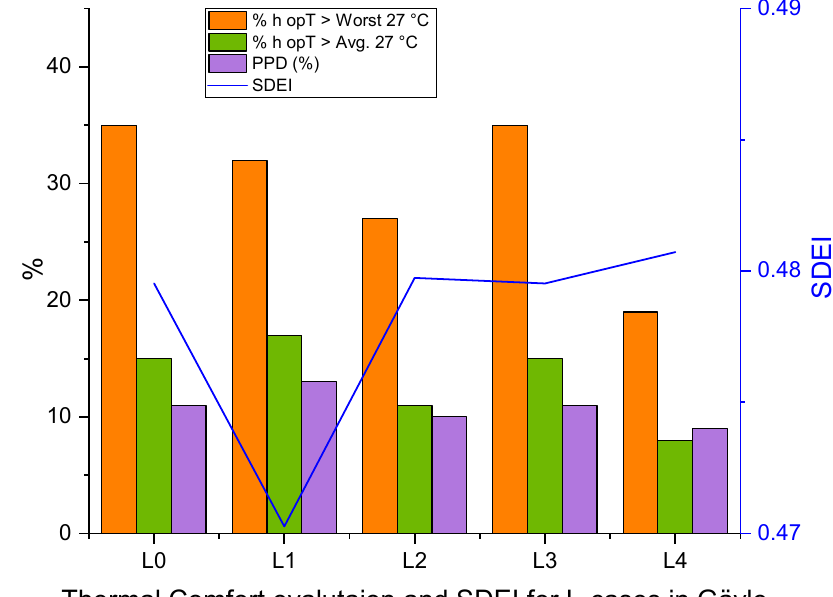
Figure 19. Thermal comfort main indicators as well as SDEIs for L0–L4 in Gävle.